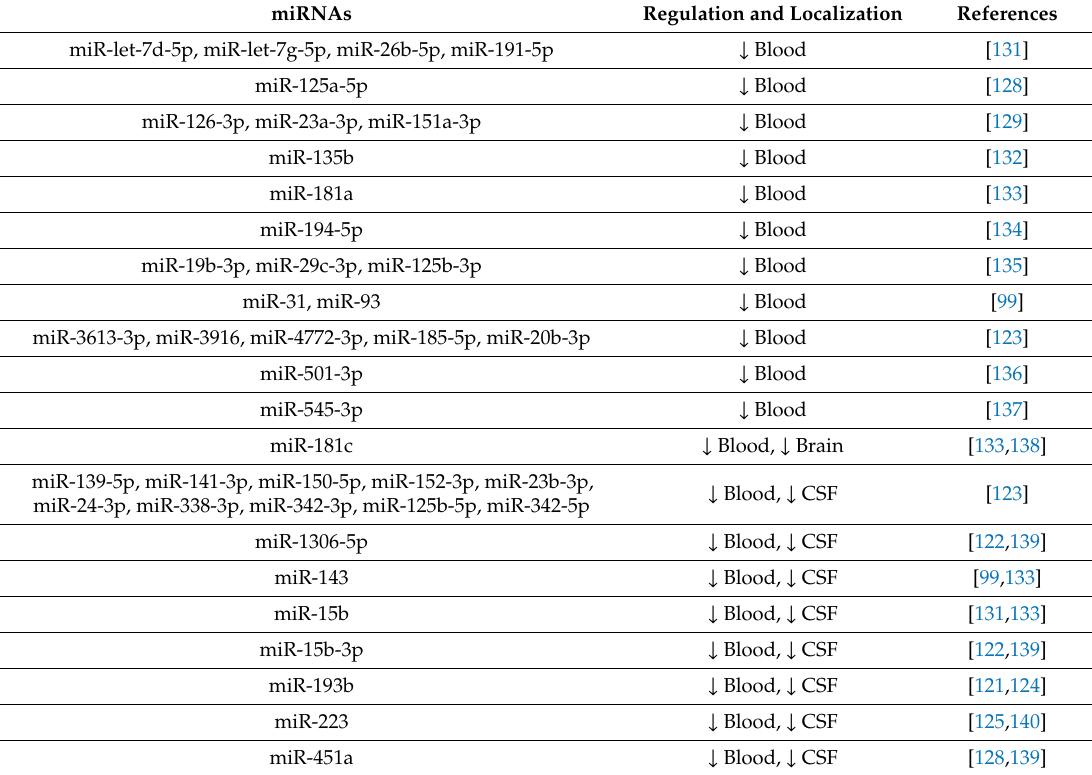
Table 2. AD-related main